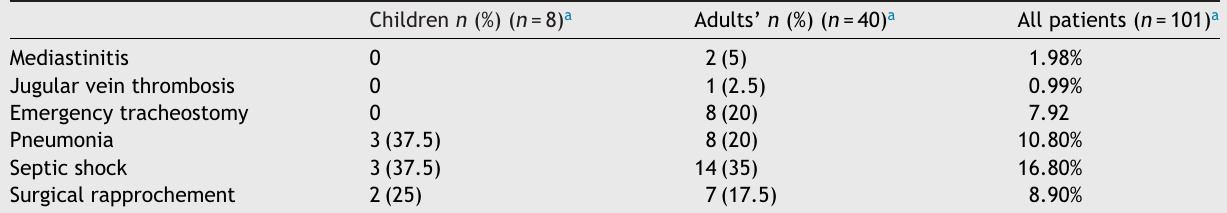
Complications of deep neck abscesses.